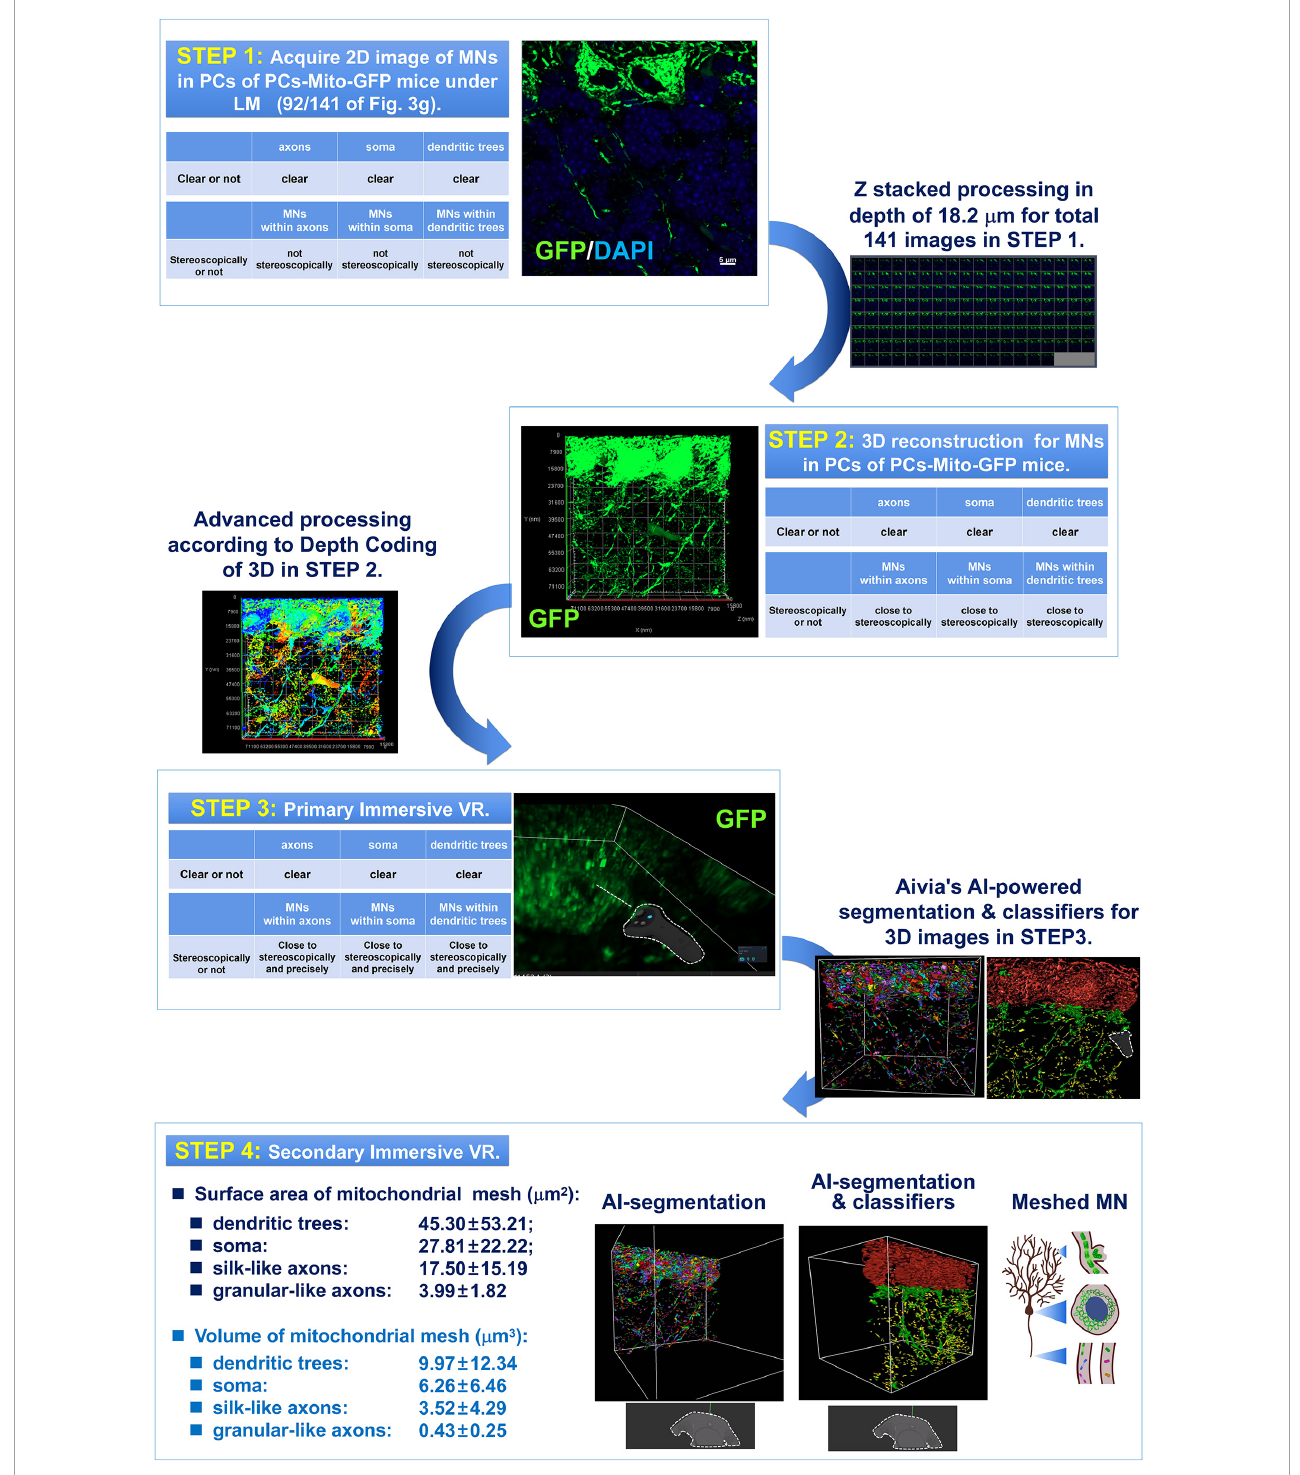
FIGURE2 Four step process composed of 2D and 3D observation as well as primary and secondary AI-powered VR were used for detection of the MNs in PCs under light-microscopy (LM). The 1st step was to acquire 2D image of MNs in PCs of PCs-Mito-GFP mice under LM. In the 1st step, although the images of axons, or soma, or dendritic trees were all clear, the MNs within axons, or soma, or dendritic trees could not be indicated stereoscopically and precisely. Then after Z stacked processing in depth of approximately 20 µ m for total more than 80 2D images in STEP 1, 3D reconstruction for MNs in PCs of PCs-Mito-GFP mice were made. In the 2nd step, the MNs within axons, or soma, or dendritic trees could be indicated close to stereoscopically. Then after advanced processing according to Depth Coding of 3D, in the Step 3 of primary immersive VR, MNs within axons, or soma, or dendritic trees could be indicated close to stereoscopically and precisely. Finally after Aivia’s AI-powered segmentation and classifiers for 3D images obtained in Step 3, we have stepped into the 4th step, in which we have for the first time found that neuronal MNs were composed by regular meshes. The surface area ( µ m 2 ) of mitochondrial meshes was the biggest in dendritic trees (45.30 ± 53.21), the smallest in axons (17.50 ± 15.19), and in the middle in soma (27.81 ± 22.22). In addition, the volume ( µ m 3 ) of mitochondrial meshes was the biggest in dendrits (9.97 ± 12.34), the smallest in axons (3.52 ± 4.29), and in the middle in soma (6.26 ±